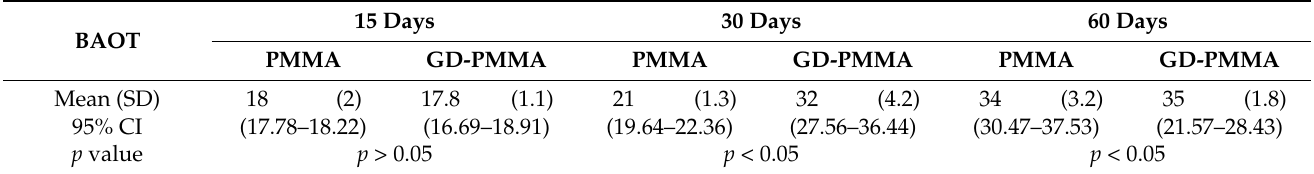
Table 3. Summary of histomorphometric micro-CT bone area outer threads (BAOT) between the PMMA implants group and GD-PMMA implants (Kruskal Wallis followed by the Bunn’s test).